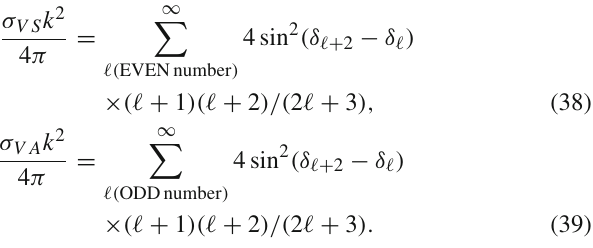
The parameter space allowed by DM relic density and the small scale structure is shown in Fig. 2 as the blue points. We